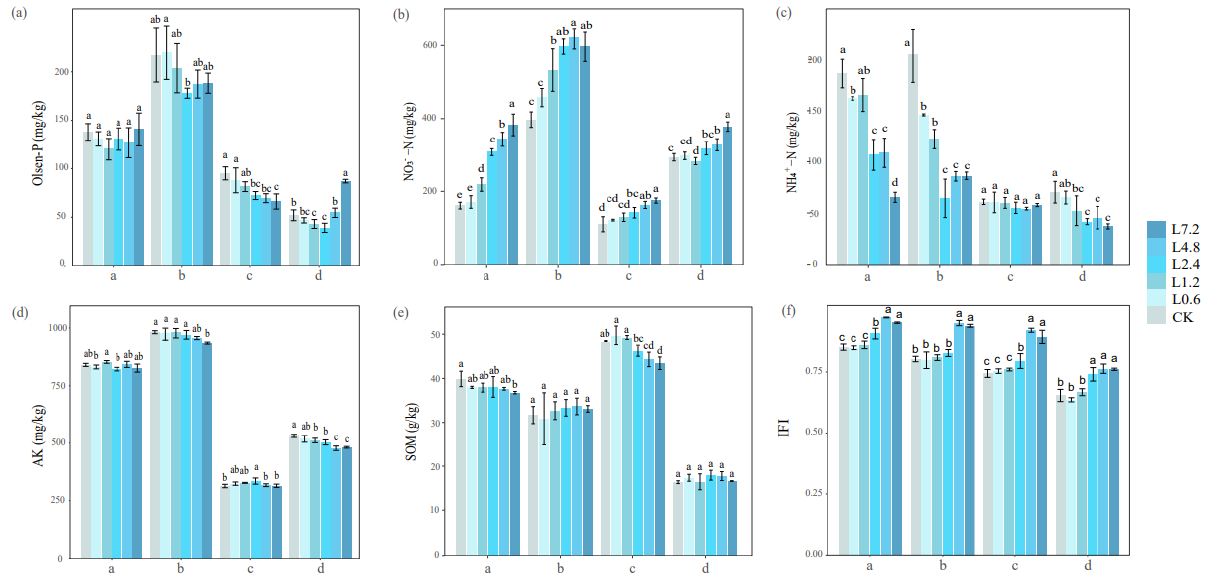
Figure 3. ( a ) Effects of liming on soil Olsen-P. ( b ) Effects of liming on soil nitrate nitrogen (NO 3- − N). ( c ) Effects of liming on soil ammonium nitrogen (NH 4+ − N). ( d ) Effects of liming on soil available potassium (AK). ( e ) Effects of liming on soil organic matter (SOM). ( f ) Effects of liming on soil integrated fertility index (IFI). In each figure, the lowercase letters under the abscissa represent soil types, different letters above each bar indicate significant differences ( p < 0.05) among different treatments of the same soil.